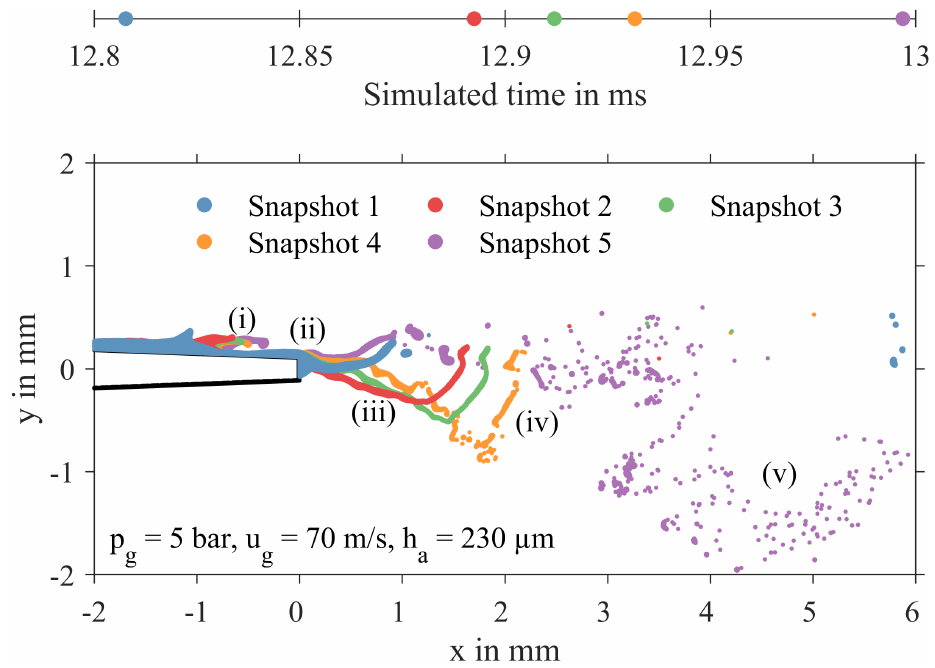
Figure 6. Breakup sequence at the prefilmer (bottom) and recording times of snapshots